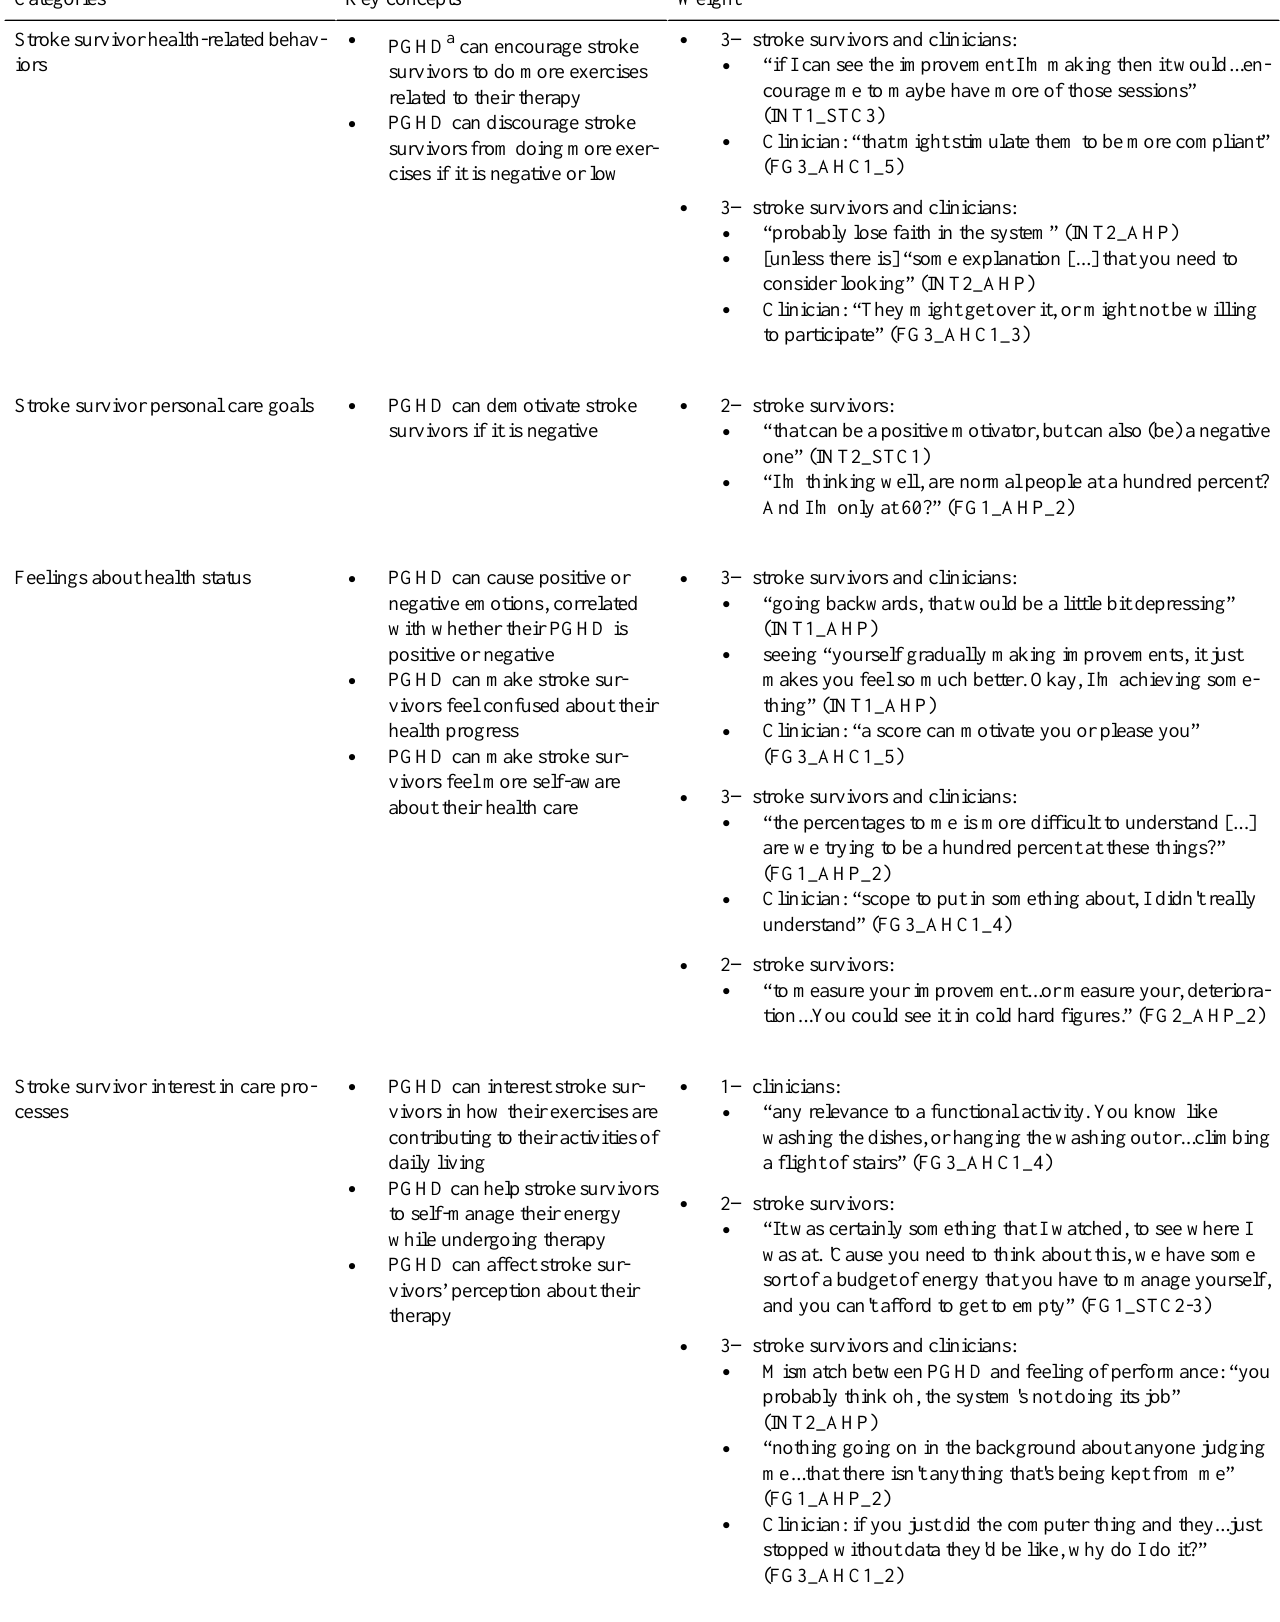
Table 2. Weighted new concepts identified from qualitative